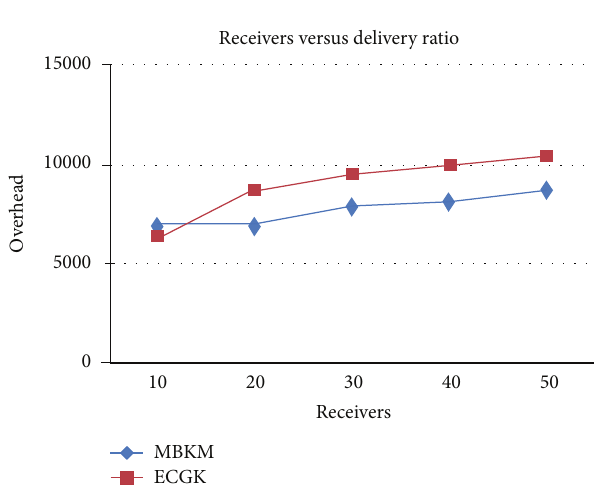
Figure 11: Comparison of overhead with ECGK for varying receivers.